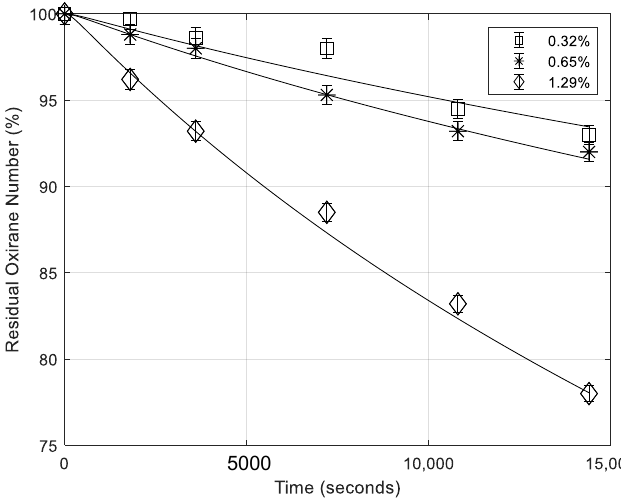
Figure 2. Residual oxirane number profiles vs. time for different sulfuric acid concentrations. Points are experimental data lines are calculated with the developed model. (temperature 70 °C; rate of agitation 750 rpm (rpm = revolutions per minute); mass of formic acid 5.38 g).